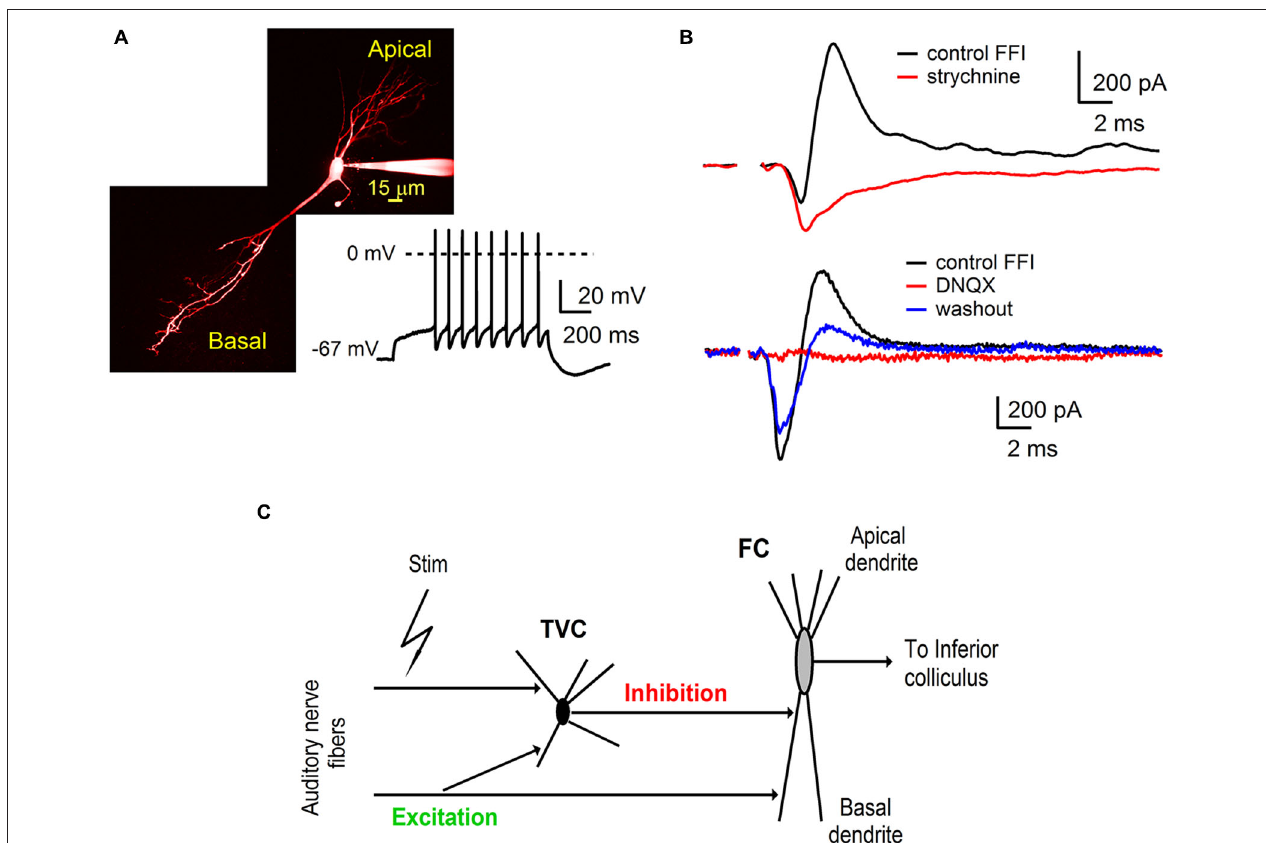
completely blocked with 2 µ M strychnine (top traces, n = 3 cells). Application of AMPA receptor antagonist 6,7-dinitrodihydroquinoxaline- 2,3-dione (DNQX) (20 µ M) reversibly blocked both components of the sequence (bottom traces, n = 5 cells). Stimulation artifacts were removed for clarity. Traces represent averages of 5–10 trials. (C) A schematic of the feed-forward inhibitory circuit driven by the auditory nerve in the dorsal cochlear nucleus. Auditory nerve fibers synapse onto FC, as well as onto tuberculoventral cells (TVC) which further provide inhibition to the